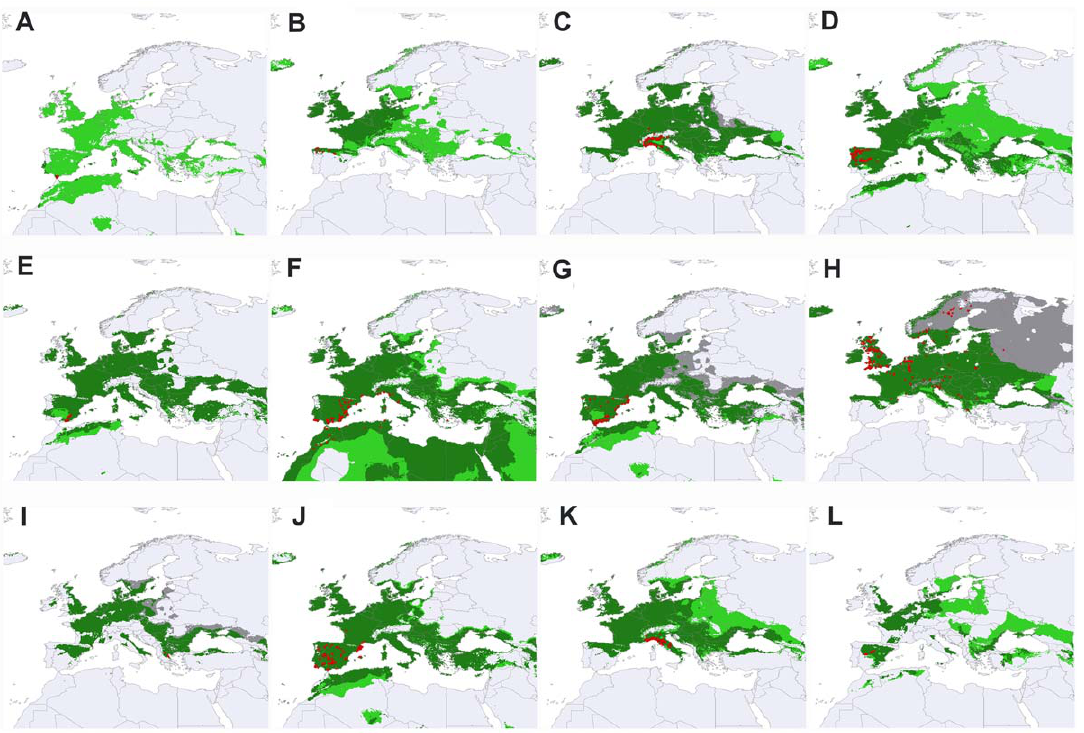
Figure 2. Potential distribution maps. Grey surface represents the area that is predicted as potential distribution only using climatic data from occurrences; light green surface represents the area that is predicted as potential distribution only using physiological tolerance; dark green surface represents the potential area shared by the two procedures (i.e. areas where both methods overlap). For each species, the combined potential distribution (CPD) using both methods is represented as the sum of the three colours. Red points indicate occupied localities. A: D. algibensis ; B: D. angusi ; C: D. aubei aubei ; D: D. bicostatus ; E: D. depresicollis ; F: D. fairmairei ; G: D. hispanicus ; H: D. latus ; I: D. mazzoldi ; J: D. opatrinus ; K: D. semirufus ; L: D. wewalkai .